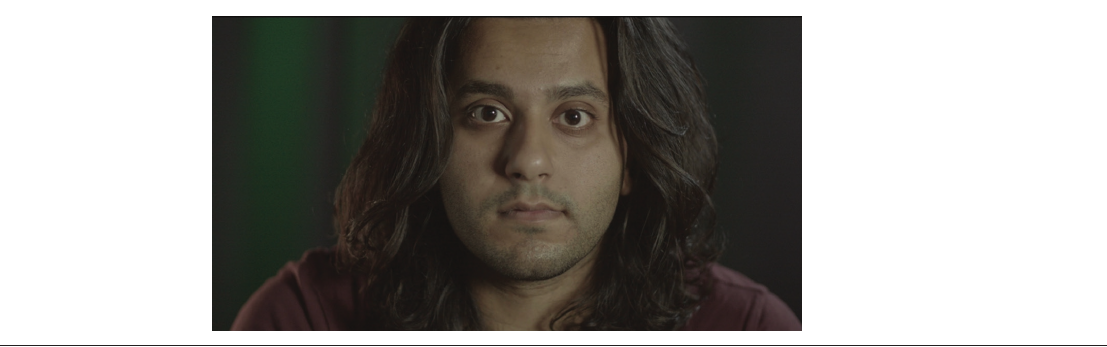
Figure 9. Close-up shot with cheerful mood by Group 1 (Source: Author, 2022)